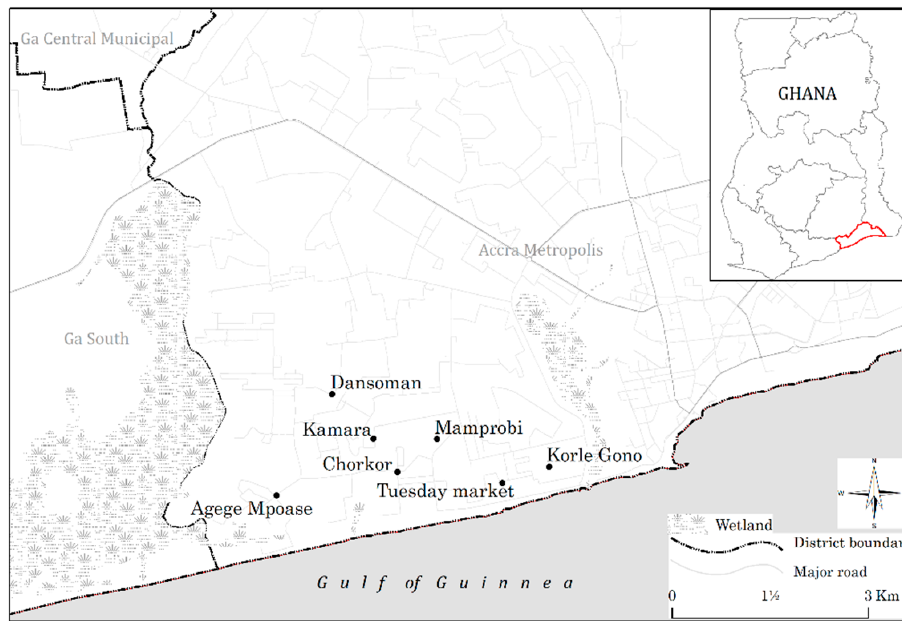
Figure 1. Map of study area.